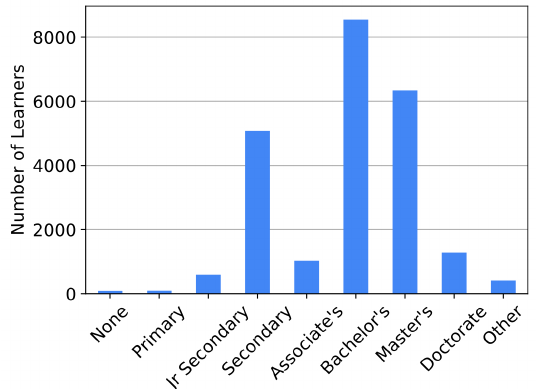
Figure 14. Education demographics based on voluntarily provided information. Many of our learners indicated an interest in TinyML to understand applied ML technologies to either pivot or grow further in their current positions.